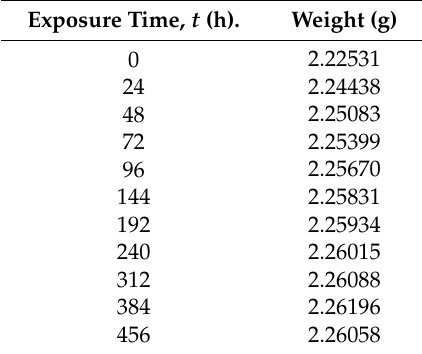
Table A1. Weight gain as a function of exposure time to 100%RH at 60 ◦ C. Exposure Time, t